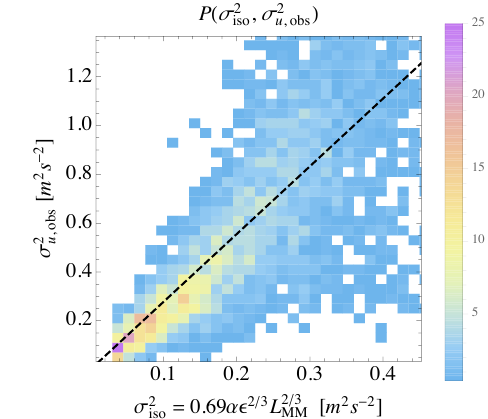
Figure 1. Joint distribution of isotropic (un-distorted) variance σ 2 ( ε,L MM ) obtained from fits to measured spectra and ob- iso served streamwise variance σ u, obs , from height z = 80m over homogeneous land sectors at Høvsøre; dashed line corresponds to σ u, obs /σ iso = 5 / 3.